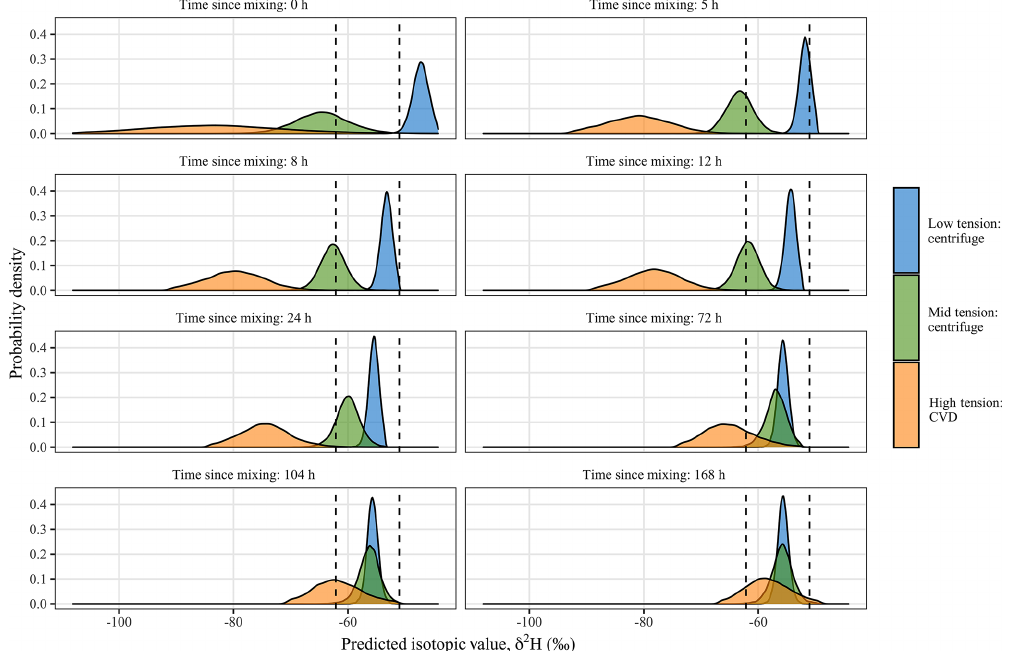
Figure 6. Time-dependent model for mixing time with distributions of δ 2 H for each of the three extracted water fractions over time in relation to the 90th credible interval for equilibrium value ( δ e , dashed lines). Panels include extraction times for the experiment as well as important time points for mixing. At 5h the median low-tension value was within the 90th credible interval of the equilibrium value. At 12h, the isotope composition of waters extracted at low and mid tension was similar to the equilibrium value. It was not until 104h ( ∼ 4 . 33d) that the median isotopic value of the water extracted at high tension was also within the 90th credible interval of the equilibrium